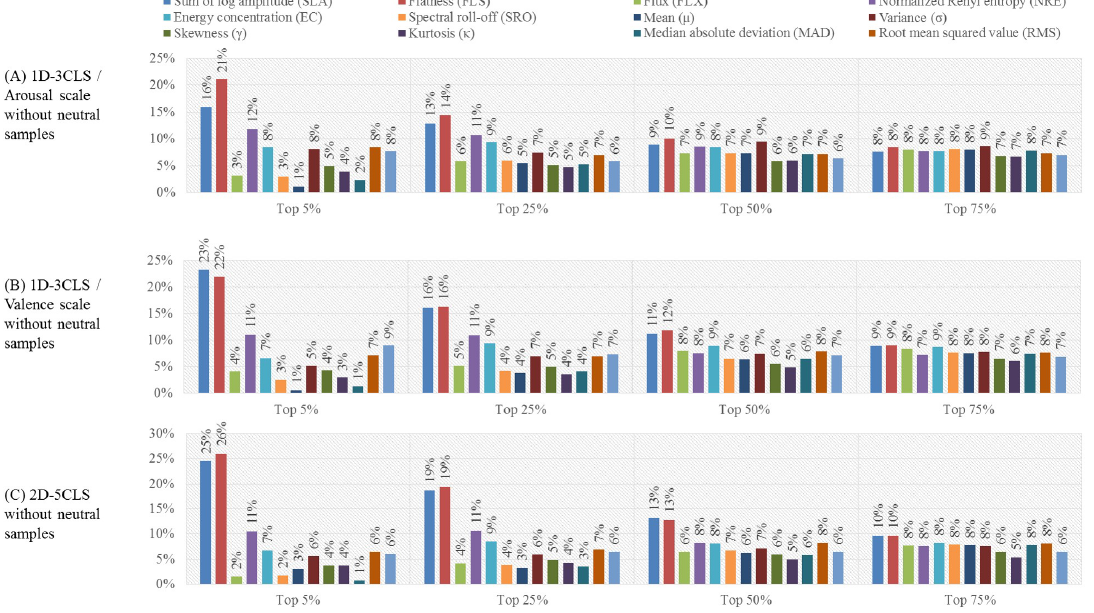
Figure 7. The ratio between the number of times each time-frequency feature is selected to the total number of selected features for each of the four feature selection scenarios after excluding the feature vectors associated with the neutral class. ( A ) presents the computed percentages for the 1D-3CLS using the arousal scale; ( B ) presents the computed percentages for the 1D-3CLS using the valence scale; and ( C ) presents the computed percentages for the 2D-5CLS using the valence